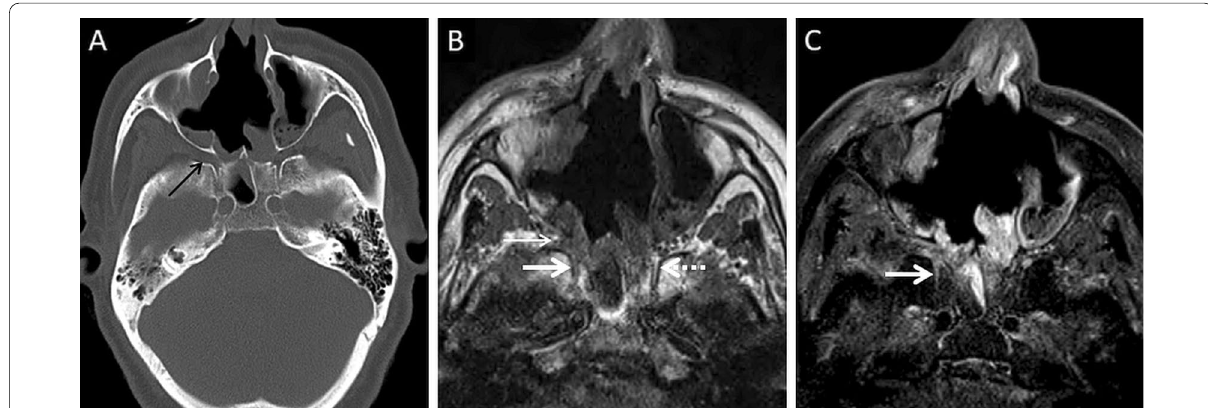
Fig. 12 Perineural spread of ROCM detected on post-operative follow-up imaging. Axial CT image ( a ), obtained using bone algorithm, reveals slight widening of the right PPF (thin arrow). Unenhanced axial T1W image ( b ) of the same patient confirms soft tissue (thin arrow) within the right PPF. Note the loss of normal fat signal within the right vidian nerve canal (thick arrow), compared to the contralateral side (dotted arrow). CE FS axial T1W image ( c ) reveals abnormal enhancement of the soft tissue within the right vidian nerve canal (thick arrow). The diagnosis of perineural invasion of MCR was suggested. There was no obvious enhancement along the greater superior petrosal nerve detected at the time of